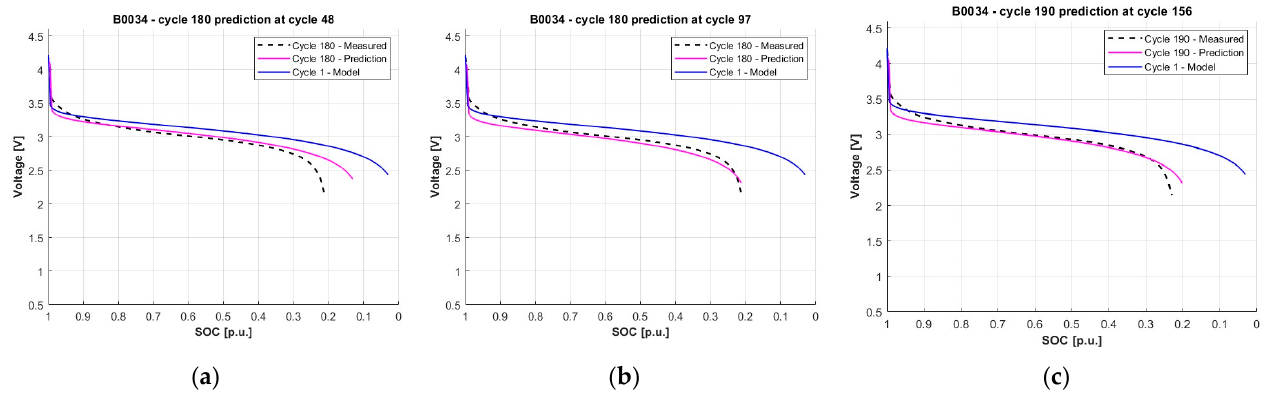
Figure 10. Prediction of future discharge cycles at different stages of cell aging for cell B0034 with a discharge current of 4 A (C-rate of 2). ( a ) Prediction of future cycle using 25% useful life data. ( b )